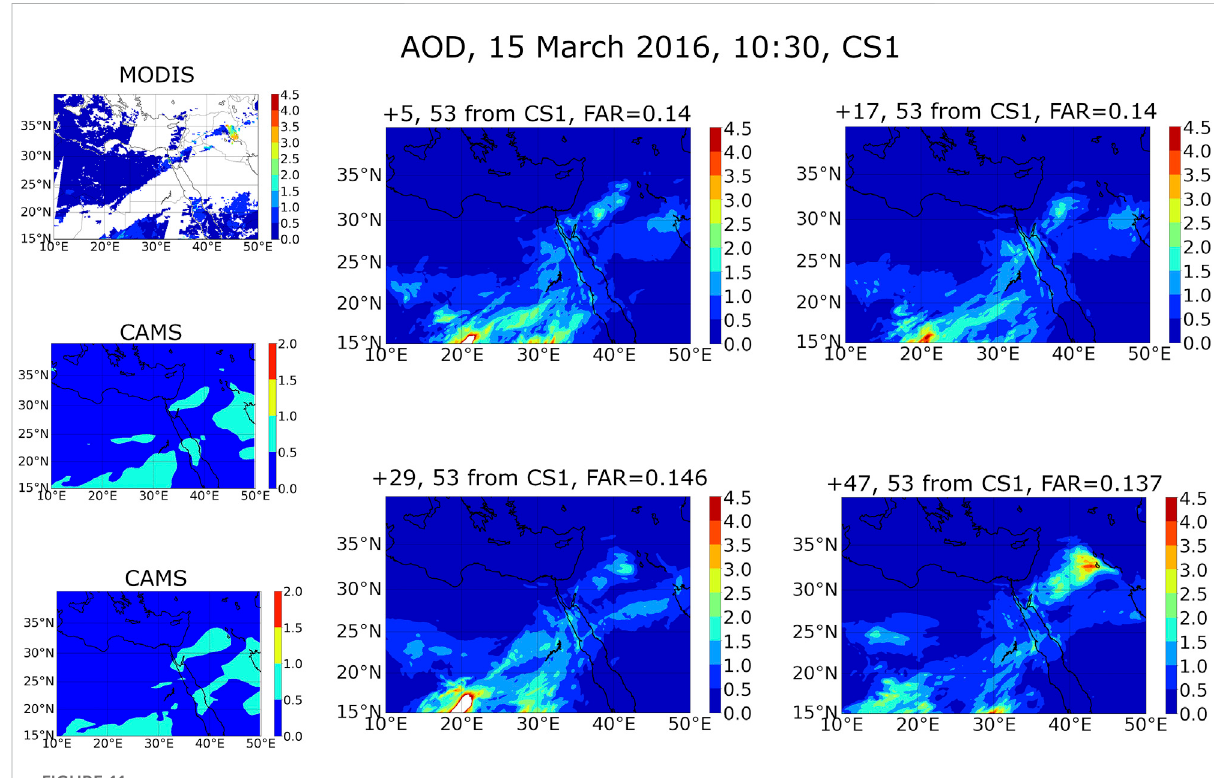
FIGURE 11 Comparison of modeled, MODIS and CAMS AOD values for 10:30 UTC (11:00 UTC for model) of 15 March 2016. The forecast lead time, time distance from the CS1 and false alarm rates are shown at the top of each modeled